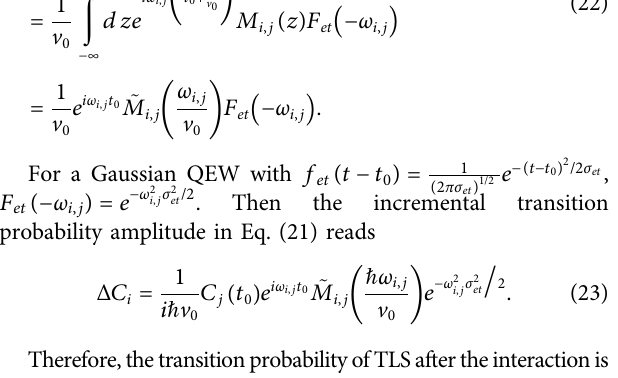
FIGURE 3 | Numerical solution of Schrodinger equation (1) and the analytical solution expressions of equation (24) for the transition probability dependence of the TLS on the QEW size: (A) for the initial TLS in the ground state and (B) for the initial TLS in a superposition state | ψ Bin (cid:1) (cid:15)(cid:15) √ (|| 1 〈 + 2i | 2 〉 ) / 5 .